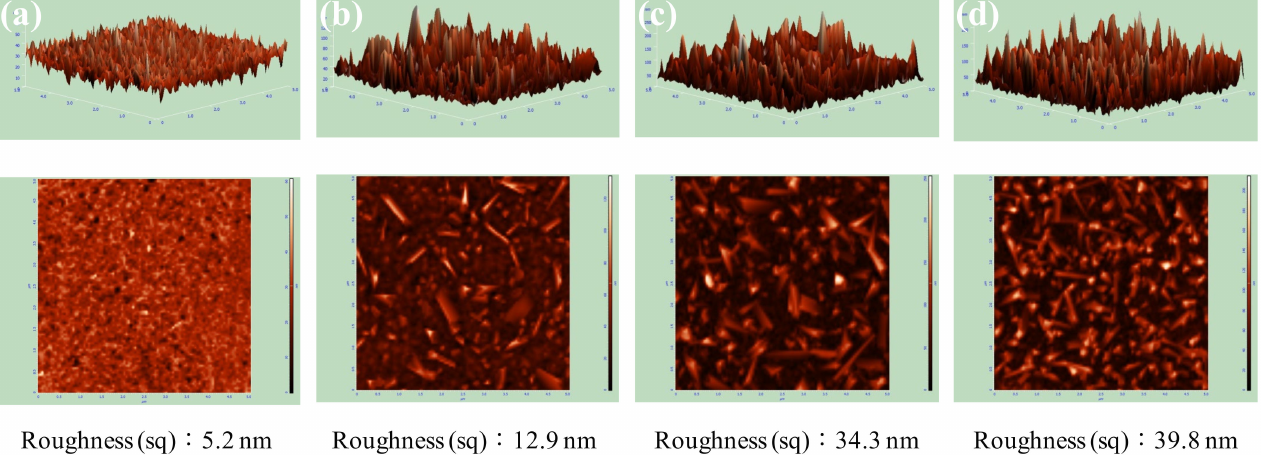
Figure 8. Surface roughness of the Mo films fabricated under different HiPIMS bias voltage ( a ) float- ing; ( b ) − 20 V; ( c ) − 40 V; ( d ) − 60